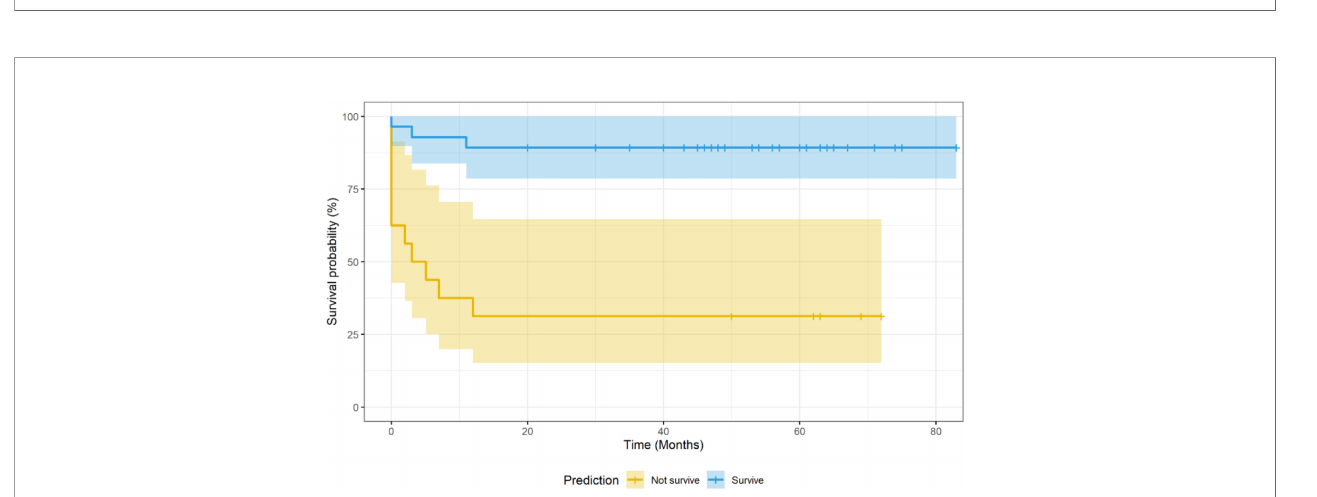
FIGURE 3 | Receiver operator characteristic (ROC) curve of the independent validation performance of the machine learning model trained over Center 1 cases to predict 2-year event-free survival over Center 2 cases with an area under the ROC (AUC) of